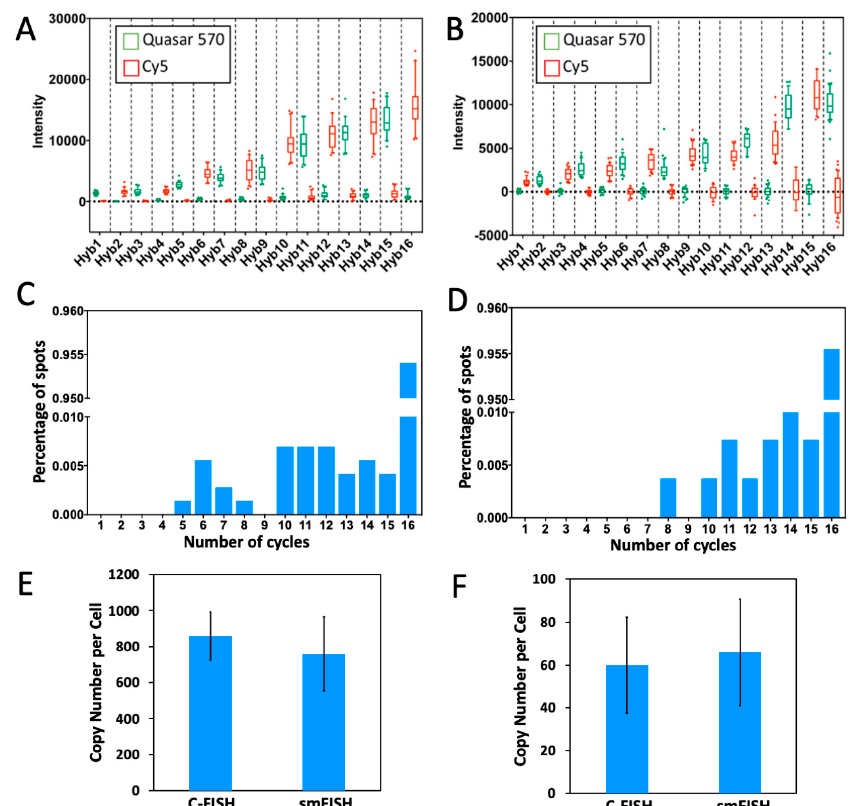
Figure 7. ( A ) Intensity distribution of the GAPDH transcripts ( n = 45 spots) in 16 cycles of C-FISH. In each cycle, the signal intensities in Quasar 570 and Cy5 channels are shown in green and red, respectively. ( B ) Intensity distribution of the Ki67 transcripts ( n = 45 spots) in 16 cycles of C-FISH. In each cycle, the signal intensities in Quasar 570 and Cy5 channels are shown in green and red, respectively. ( C ) Fraction of GAPDH spots ( n = 1000 spots) appearing in di ff erent number of C-FISH cycles. ( D ) Fraction of Ki67 spots ( n = 1000 spots) appearing in di ff erent number of C-FISH cycles. ( E ) Comparison of the GAPDH mean copy number per cell ( n = 30 cells) of transcripts measured by C-FISH and conventional single molecule FISH (smFISH) ( p > 0.41). ( F ) Comparison of the Ki67 mean copy number per cell ( n = 30 cells) of transcripts measured by C-FISH and conventional single molecule FISH (smFISH) ( p > 0.55).